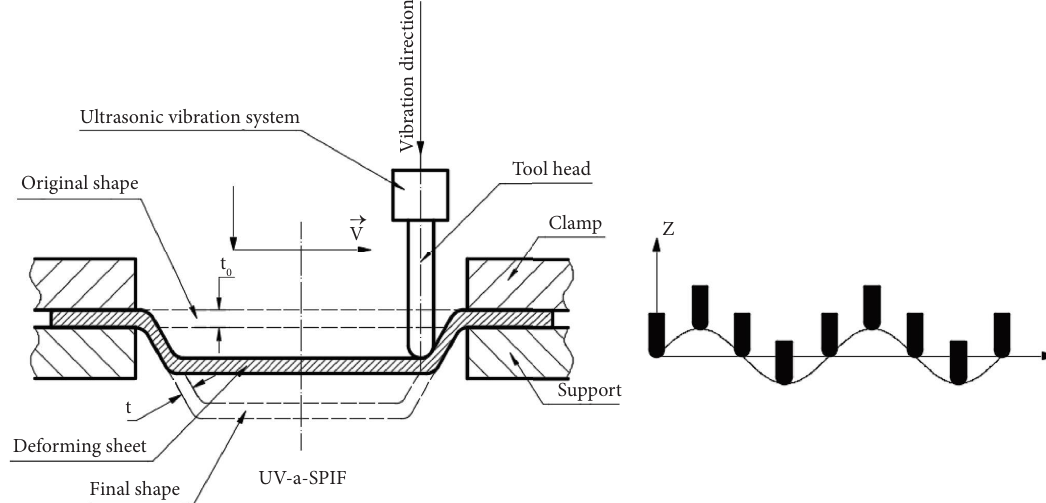
Figure 1: Schematic of the UV-a-SPIF process with sinusoidal horizontal movement of the